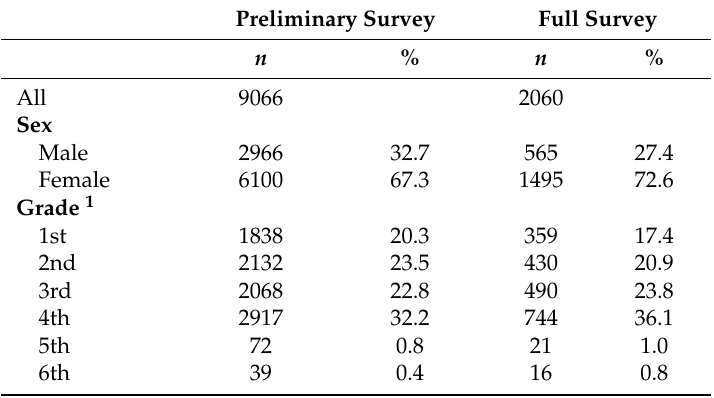
Table 1. Characteristics of surveyed